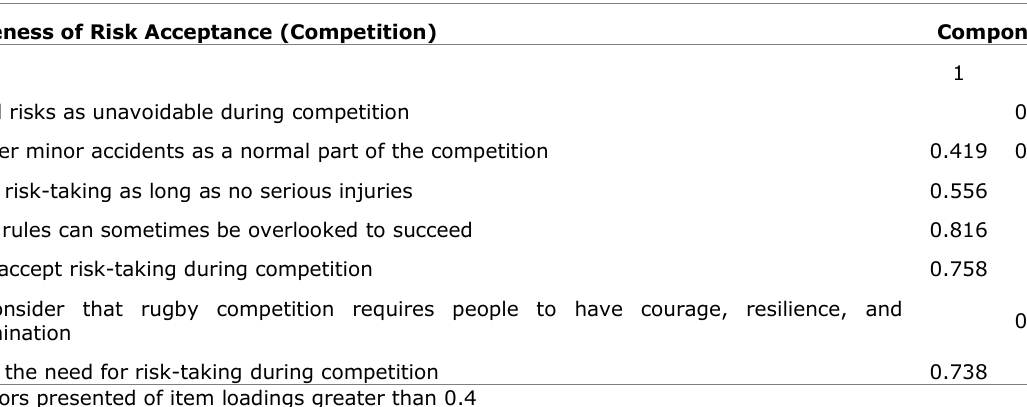
Table 8. Section 6 Rotated Component Matrix